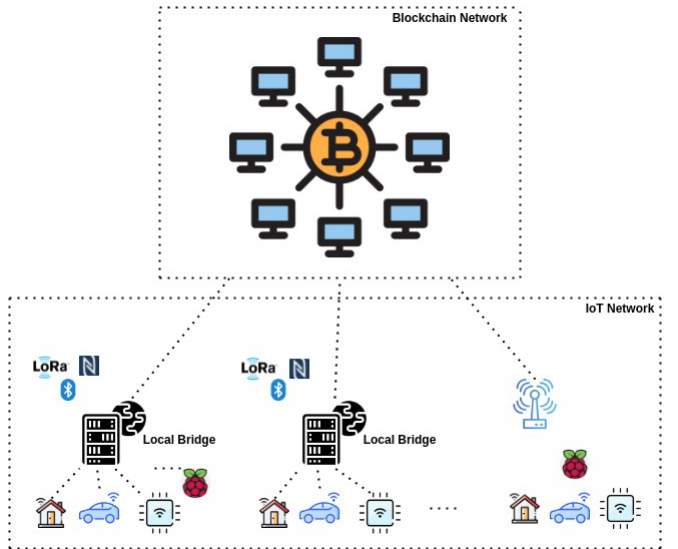
Figure 1. Traditional IoT blockchain